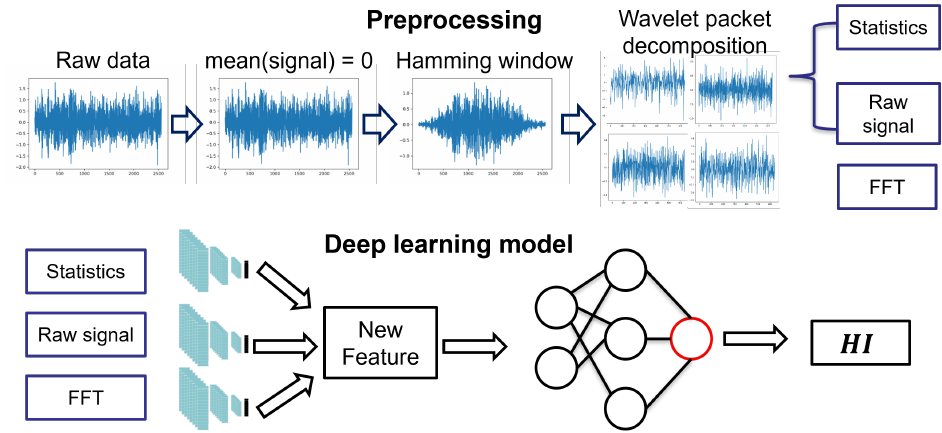
Figure 2. Procedure of proposed framework for estimating